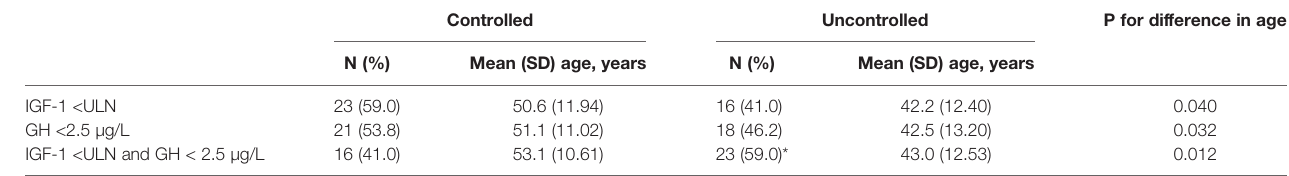
TABLE 3 | Biochemical control of acromegaly — patient distribution and